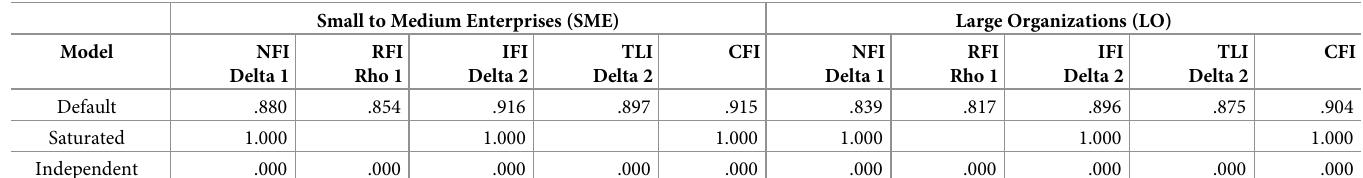
Table 4. Baseline